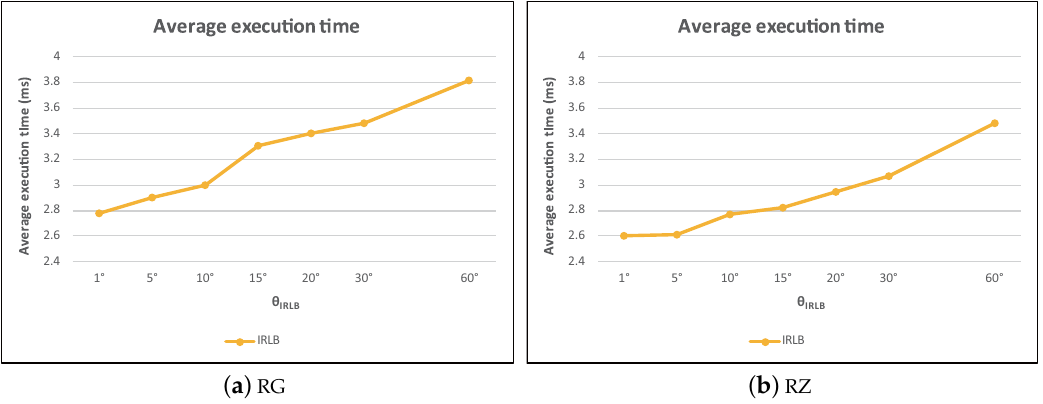
Figure 30. Average execution time vs. θ IRLB